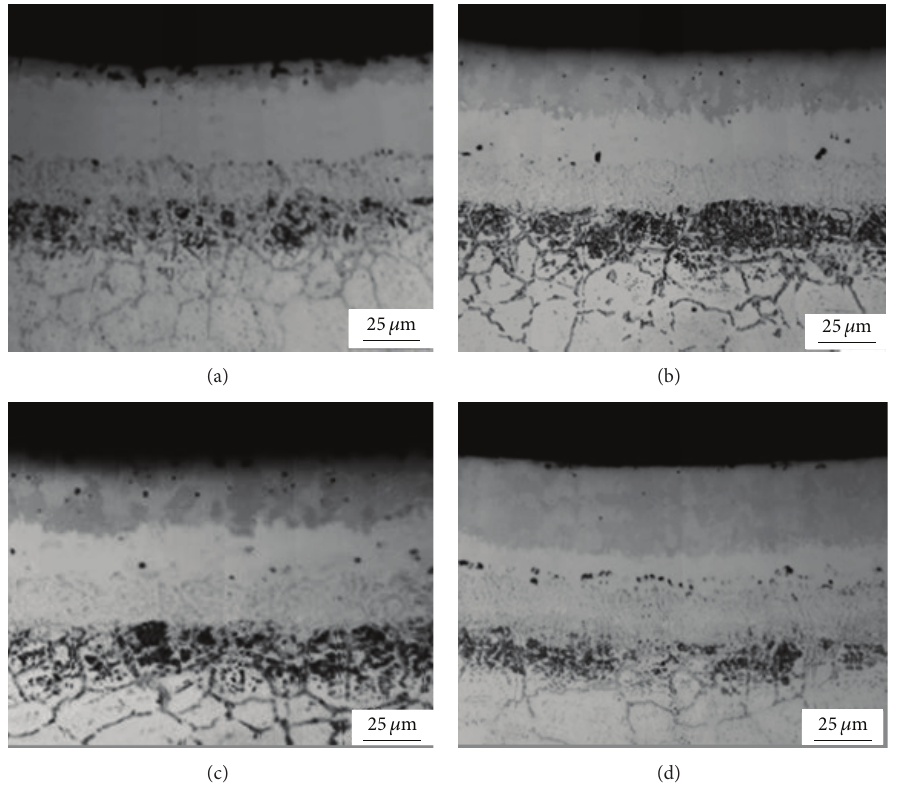
Figure 4: Optical view of the cross-section of the AISI 316L steel borided at a temperature of 1273 K with 6 h of exposure with an inner diameter of (a) 3.17, (b) 4.76, (c) 6.35, and (d) 7.93 mm.